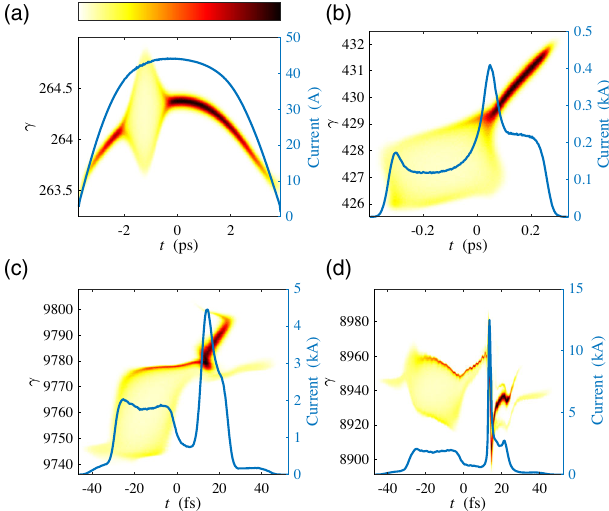
FIG. 5. Generation of a single high-current spike at the LCLS-II cuS beamline. Longitudinal phase space: (a) after laser heater; (b) after the first bunch compressor; (c) after the second bunch compressor; (d) at the entrance of soft x-ray undulator. The colorbar above (a) shows the relative density for each plot. See